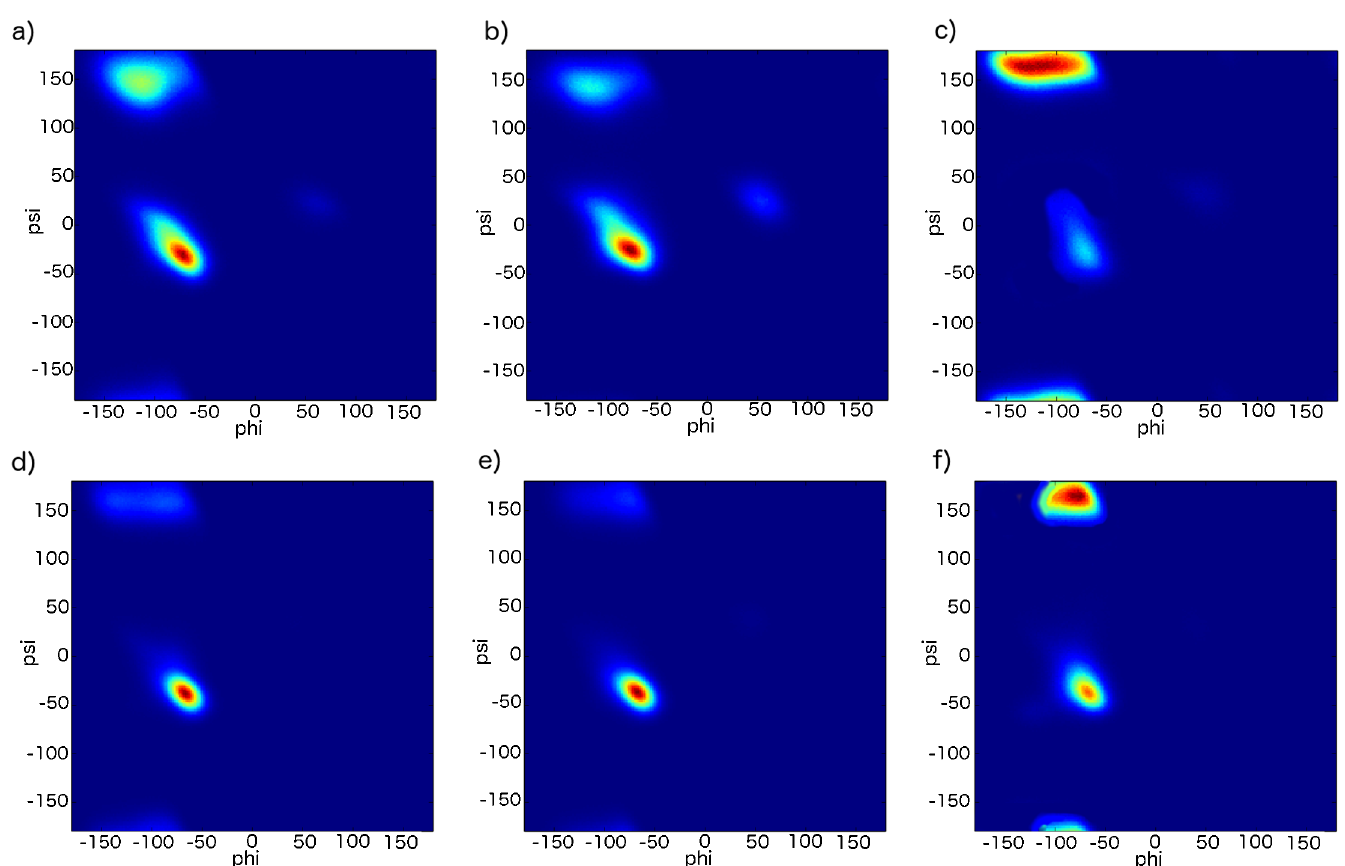
Fig 9. Ramachandran maps of non-Gly residues after the introduction of the dihedral potentials in the CamTube force field. Residues are grouped according to their propensity for particular regions in the Ramachandran map: a) Arg, Cys, Met, Leu, Ser, Trp; b) Asn, Asp, His; c) Ile, Phe, Thr, Tyr, Val; d) Ala, Gln; e) Glu, Lys; f)